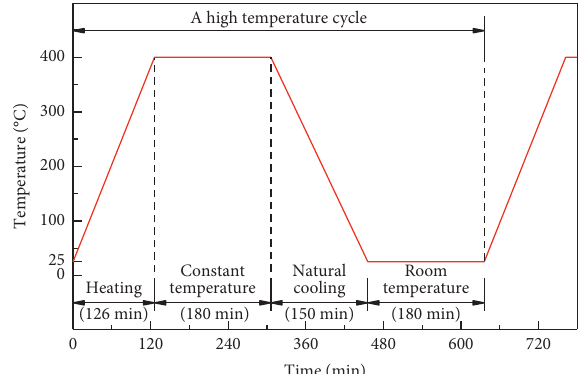
Figure 2: Temperature change curves during heating